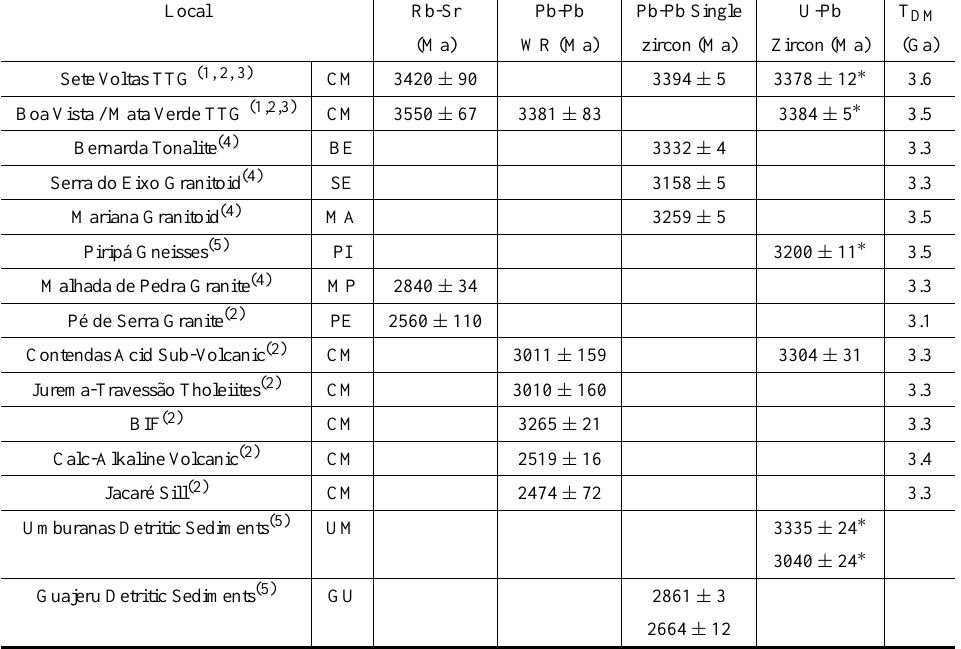
Gavião Block. Ages of the Archean main plutonic and supracrustal rocks according to different radiometric methods. Martin et al. (1991) (1), Marinho (1991) (2) Nutman and Cordani (1994) (3), Santos Pinto (1996) (4), Bastos Leal (1998) (5). Asterisks represent SHRIMP data. WR = Whole Rock. Local Sete Voltas TTG (1, 2, 3) CM Boa Vista / Mata Verde TTG